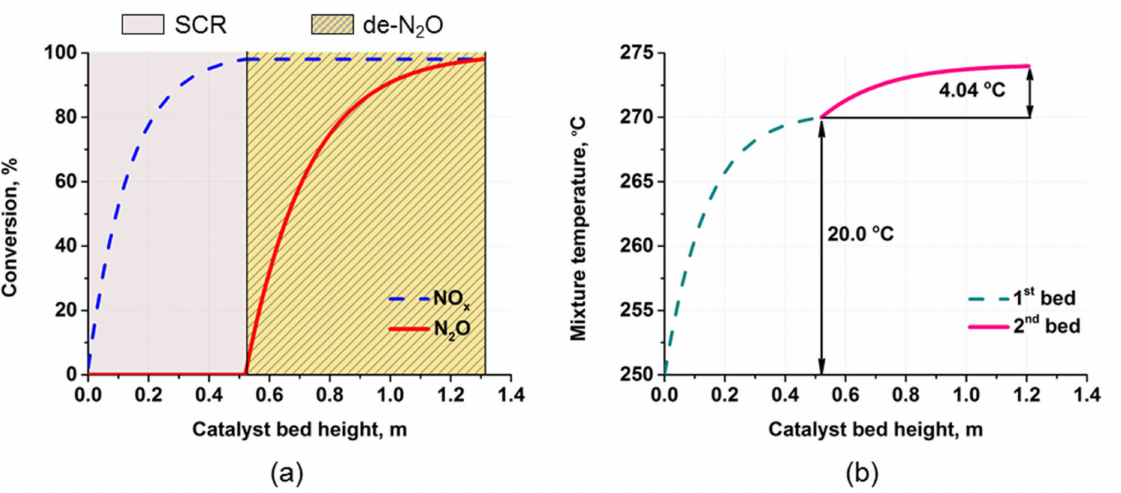
Figure 2. Conversion ( a ) and temperature ( b ) profiles along the bed heights at T in g = 250 ◦ C and Q = 58,670 m 3